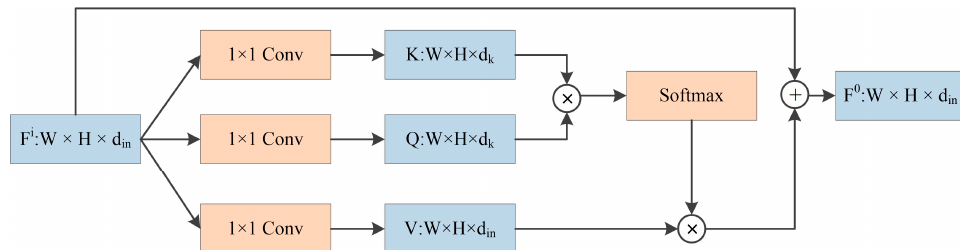
Figure 2. Architecture of the self-a tt ention mechanism.